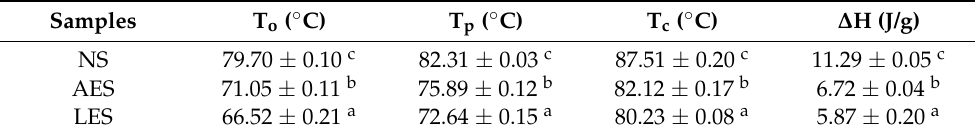
Table 2. Thermal parameters of native and organic acid treated talipot starches.